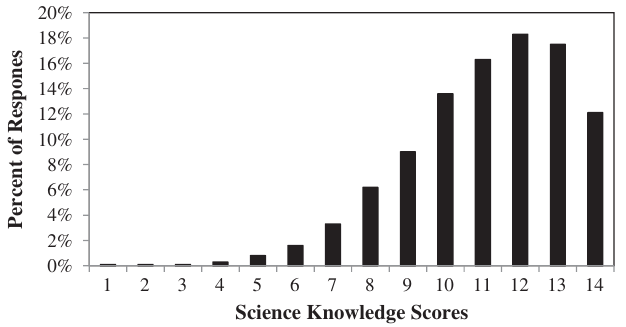
FIG. 1. Distribution of basic science knowledge scores ( n ¼ 12 676 ).